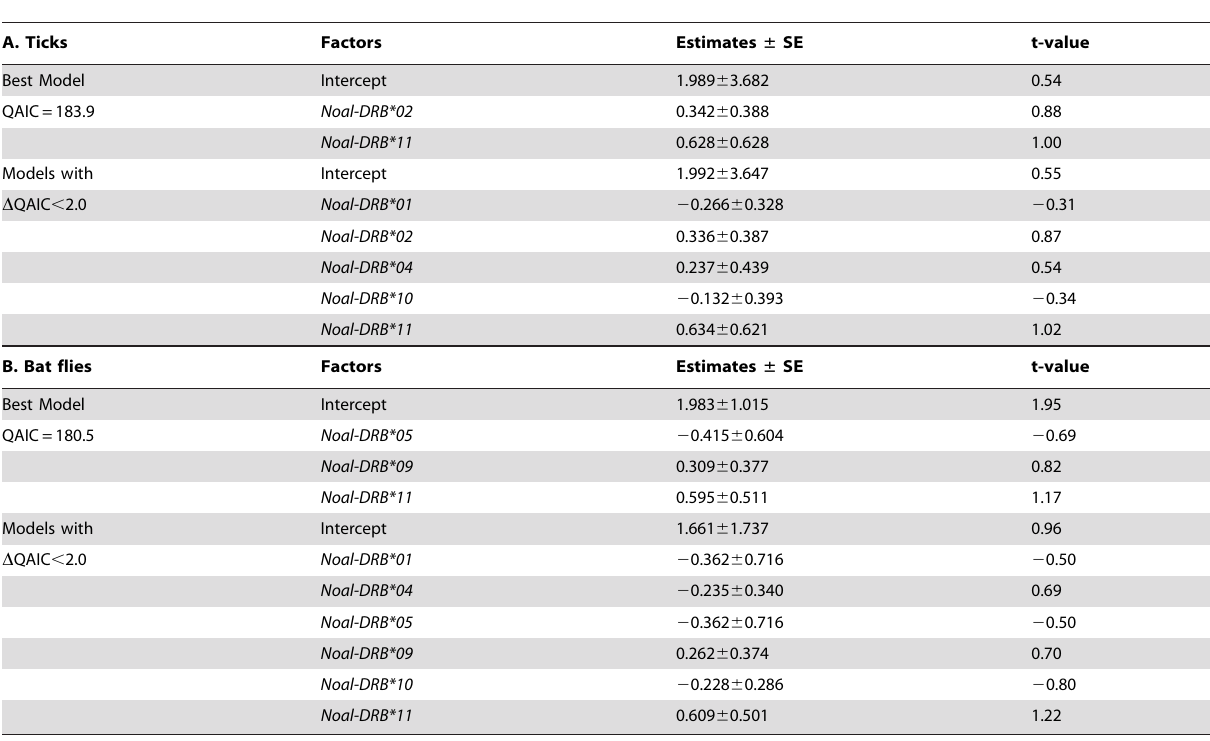
Table 1. MHC class II DRB alleles influencing ectoparasite infestation in N. albiventris